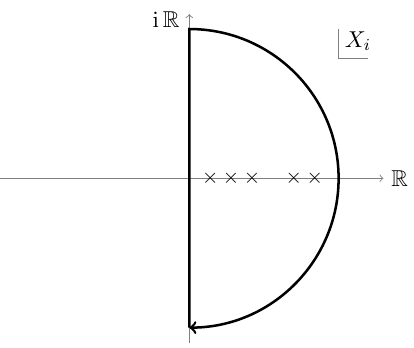
. The crosses indicate S 3 b